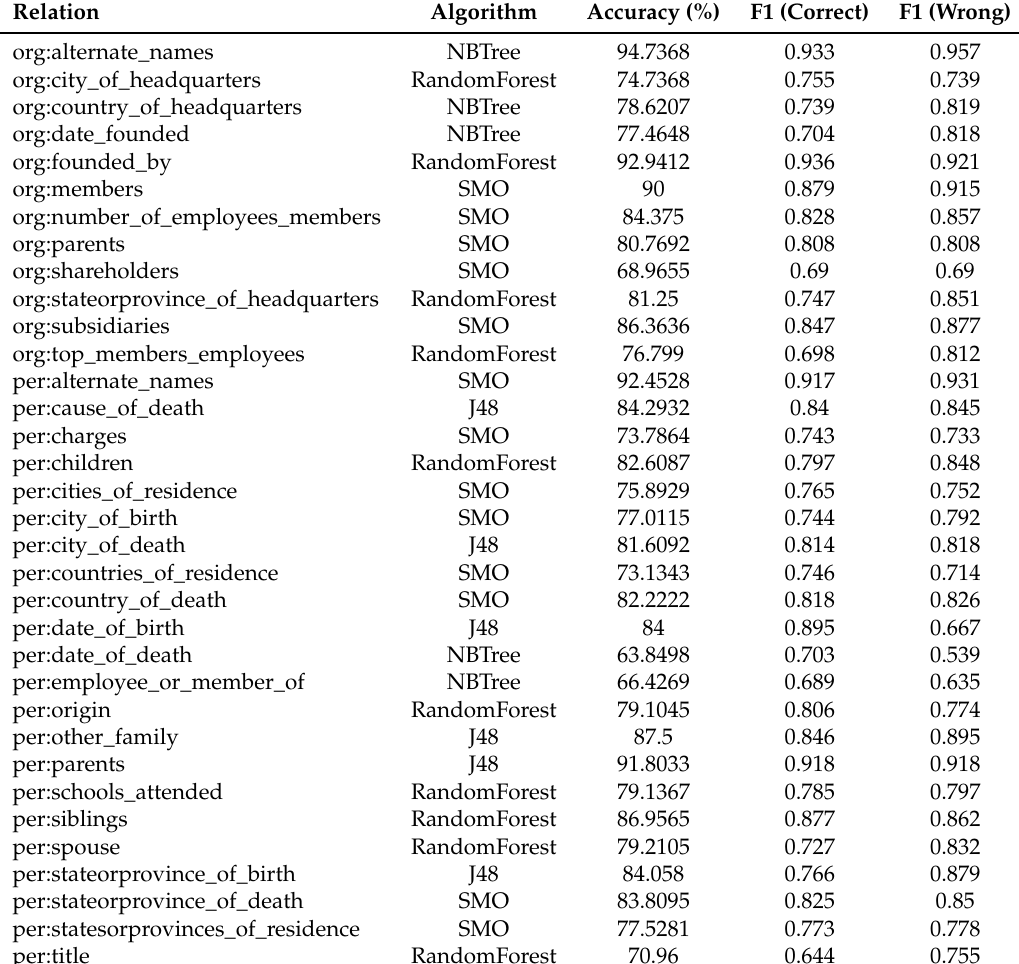
Table 4. Classifier performances on train set for Relation Factory by cross-validation